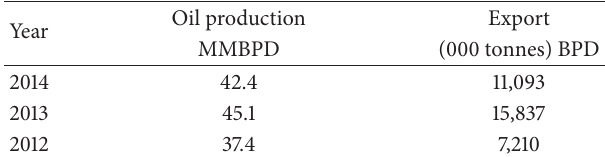
Table 11: ORC oil products (ton/year)